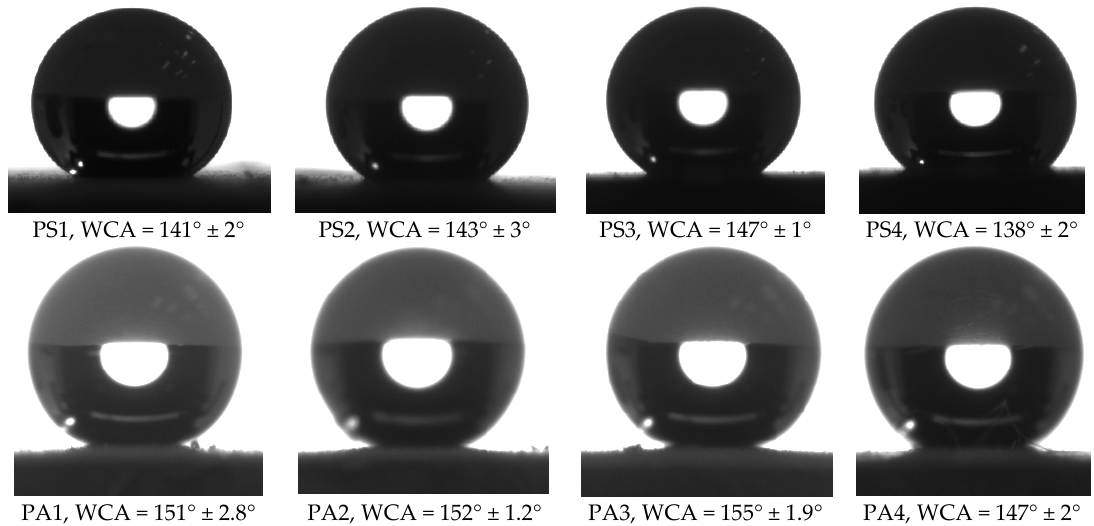
Figure 4. Snapshots of the measured water contact angle after and before the addition of Al 2 O 3